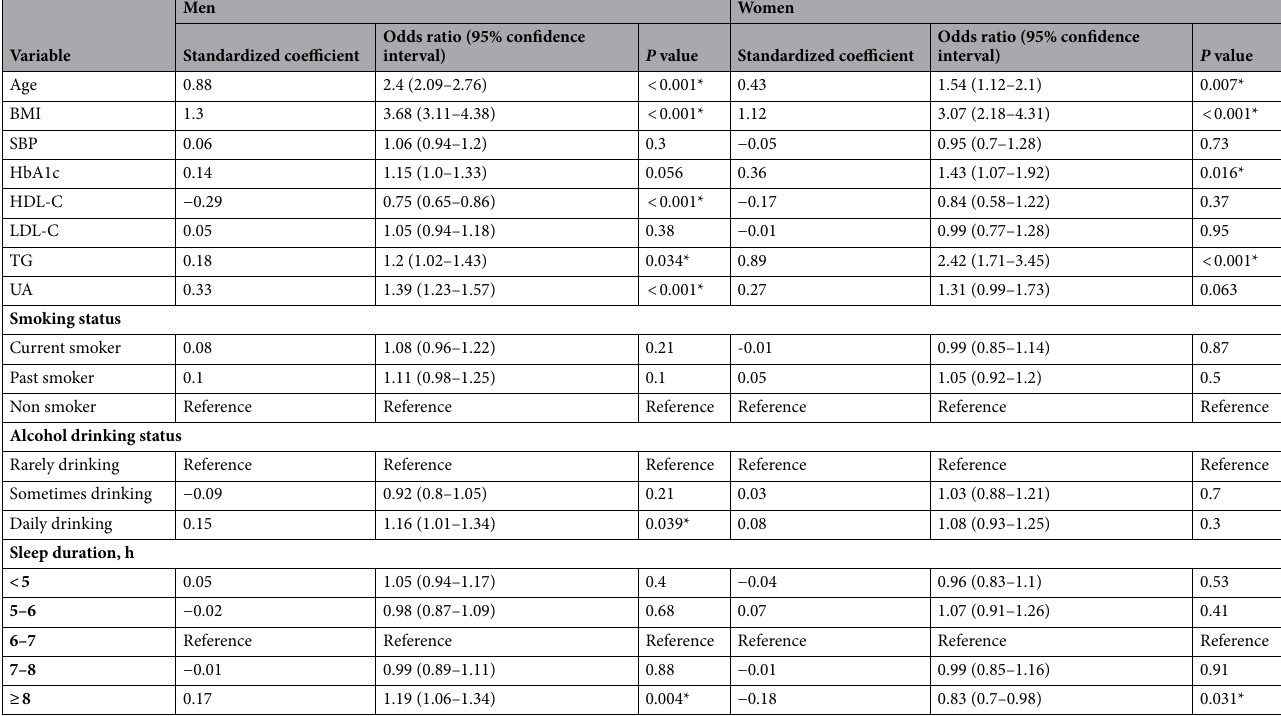
Table 3. Multiple logistic regression analyses assessing the association between visceral obesity and the background factors. Multiple logistic regression analyses were performed. * p-values indicate statistically